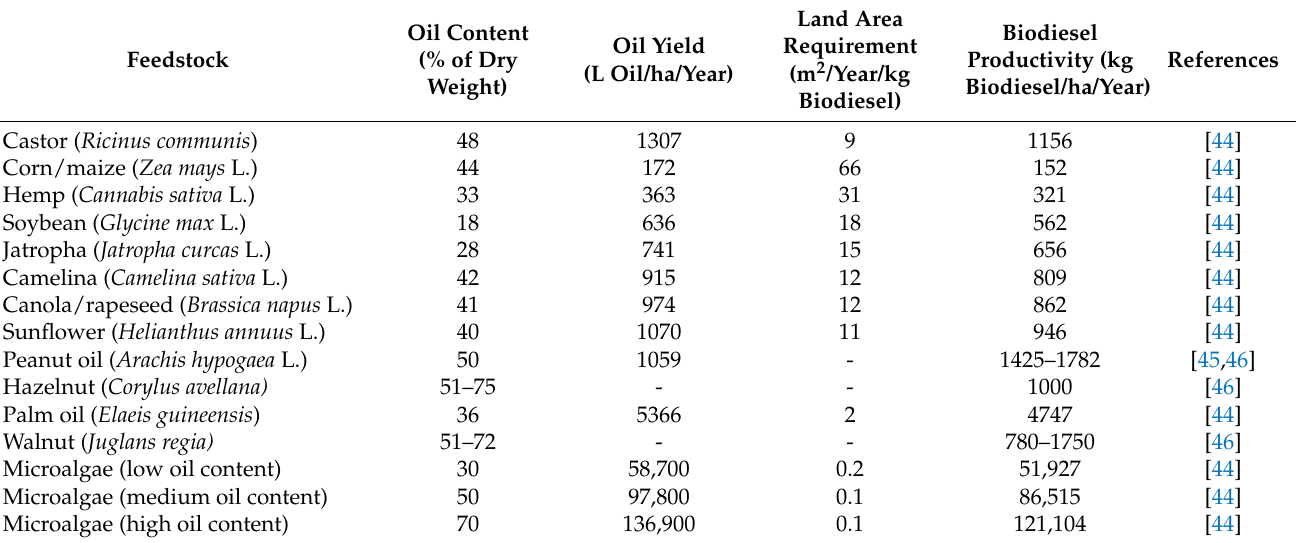
Table 1. Oil content, oil yield, land area requirement, and biodiesel productivity for several feedstocks used in biodiesel production